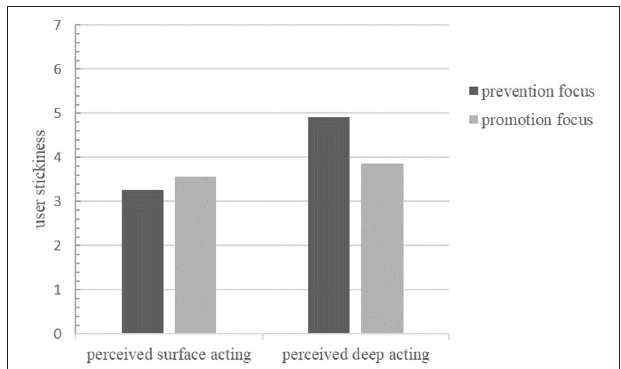
FIGURE 3 | Comparison of user stickiness with different regulatory focus.